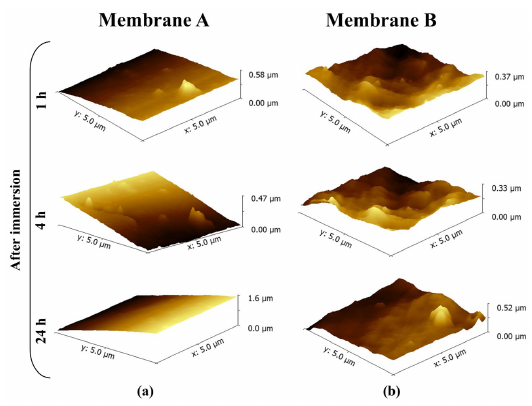
Figure 3. Topographic AFM images of (a) membrane A and (b) membrane B , obtained before and after 1, 4 and 24 h of immersion in 0.1 mol/L KCl,